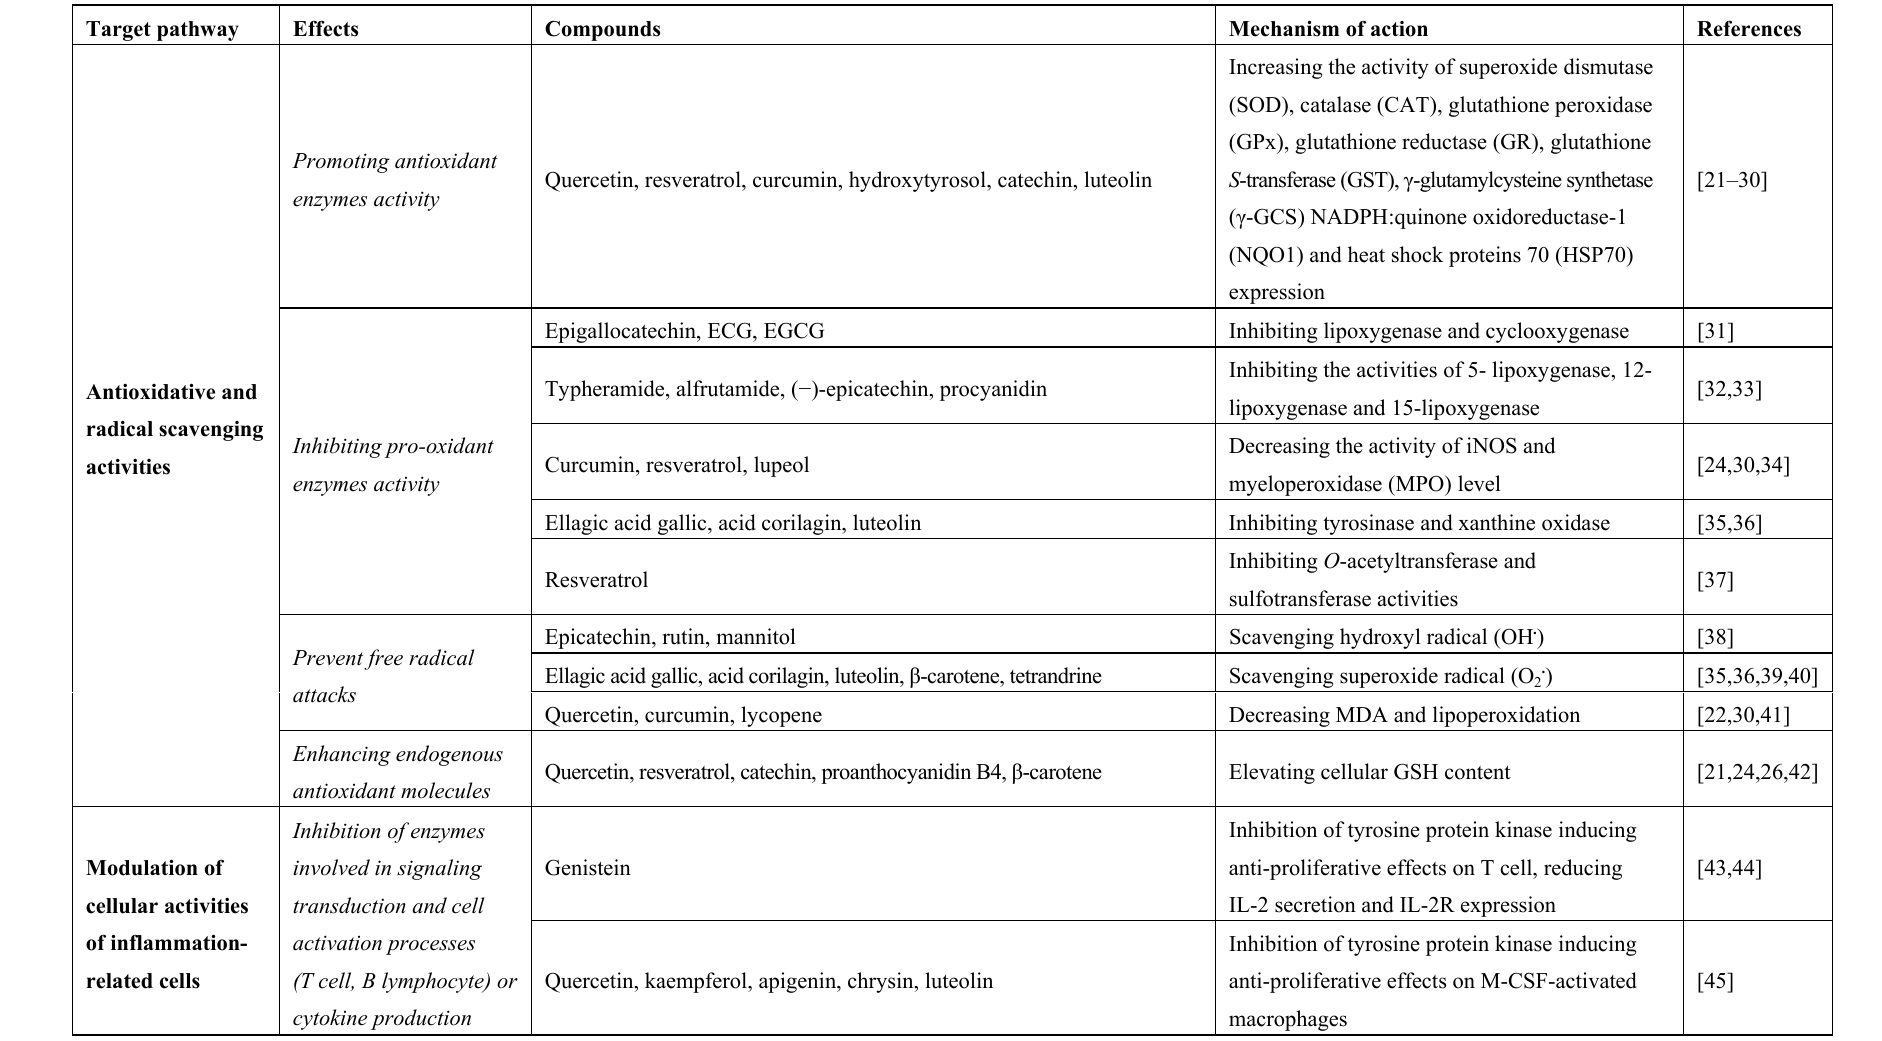
Table 1. Anti-inflammatory activities of